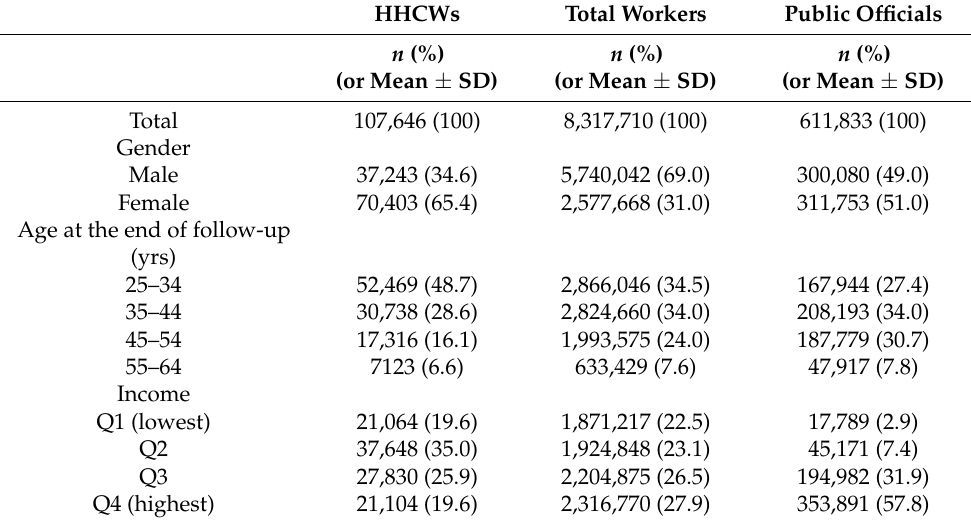
Table 1. Descriptive statistics of the